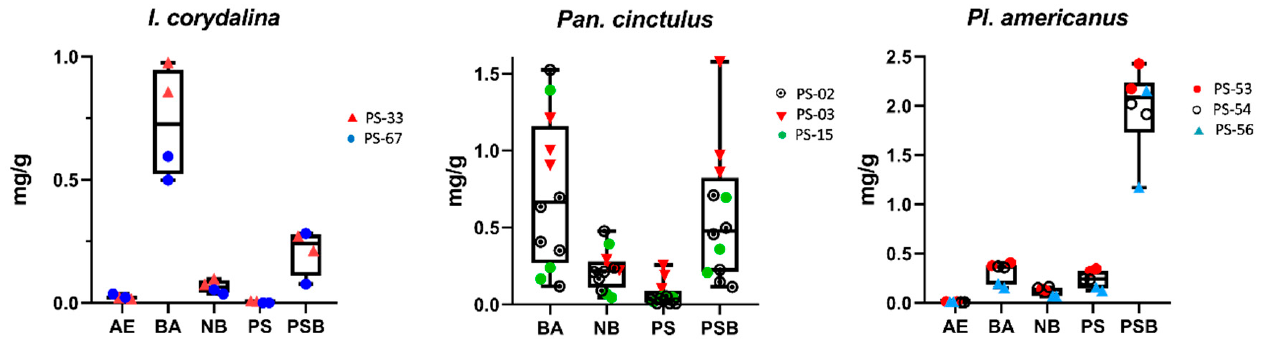
Figure 2. Tryptamine concentrations (mg/g in dry mass) in non- Psilocybe mushroom species are presented in boxplots for a minimum of two independent collections. The line in the boxplot represents the median and the whiskers signalize the minimum and maximum of the measured values. Tryptamine abbreviations: psilocybin (PSB), psilocin (PS), baeocystin (BA), norbaeocystin (NB), and aeruginascin